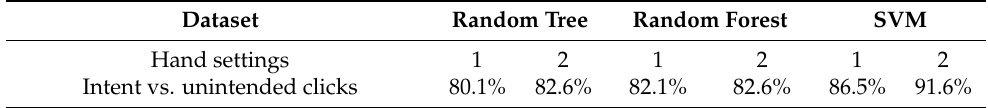
Table 6. Classification results on Dataset 2 for